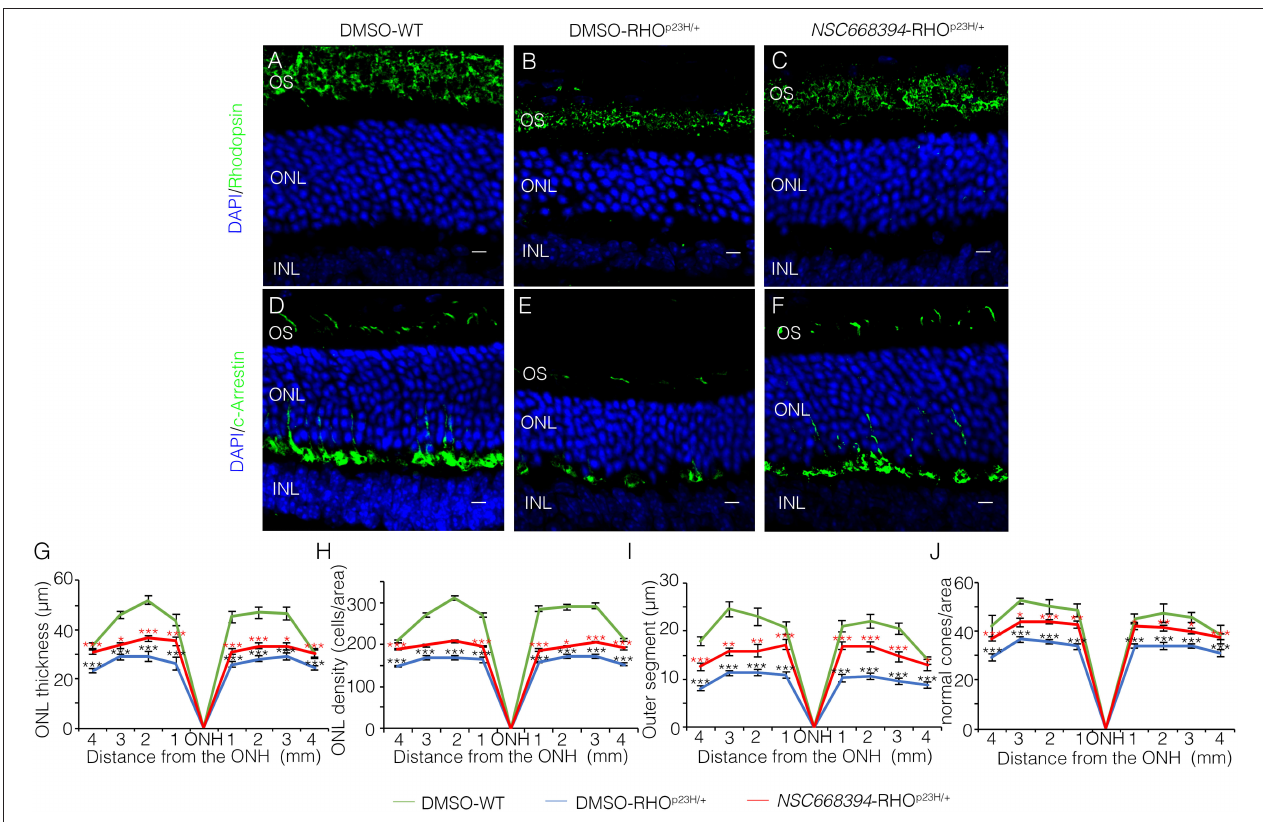
FIGURE 2 | Two-months-old NSC668394 -treated RHO P23H / + mice show retinal morphology recovery. Representative images of retina cryosection immunostained with anti-Rhodopsin (A–C) and anti- c -Arrestin (D,F) antibodies from DMSO-treated WT (A,D) , DMSO-treated RHO P23H / + (B,E) and NSC668394 -treated RHO P23H / + (C,F) mice at PN60. Nuclei are counterstained with DAPI (blue). At least n = 5 mice per group. Scale bar 10 µ m. OS, outer segment; ONL, outer nuclear layer; INL, inner nuclear layer. (G) Graphs show the measure of ONL thickness from the retina of DMSO-treated WT (green line), DMSO-treated RHO P23H / + (blue line), and NSC668394 -treated RHO P23H / + (red line) mice at 2 months of age. (H) Graphs show measure of ONL density (cells/area) from the retina of DMSO-treated WT (green line), DMSO-treated RHO P23H / + (blue line), and NSC668394 -treated RHO P23H / + (red line) mice at 2 months of age. (I) Graphs show the reduction of OS length from 2 months of age onward from each analyzed retina region of DMSO-treated WT (green line), DMSO-treated RHO P23H / + (blue line) and NSC668394 -treated RHO P23H / + (red line) mice. (J) Graphs show normal cone morphology (cones/area) from the retina of DMSO-treated WT (green line), DMSO-treated RHO P23H / + (blue line), and NSC668394 -treated RHO P23H / + (red line) mice at 2 months of age. Error bars represent SEM. *** p ≤ 0.005, ** p ≤ 0.01, * p ≤ 0.05 t -test. (DMSO-RHO P23H / + vs. DMSO-WT; NSC668394 -RHO P23H / + vs. DMSO-RHO P23H / +